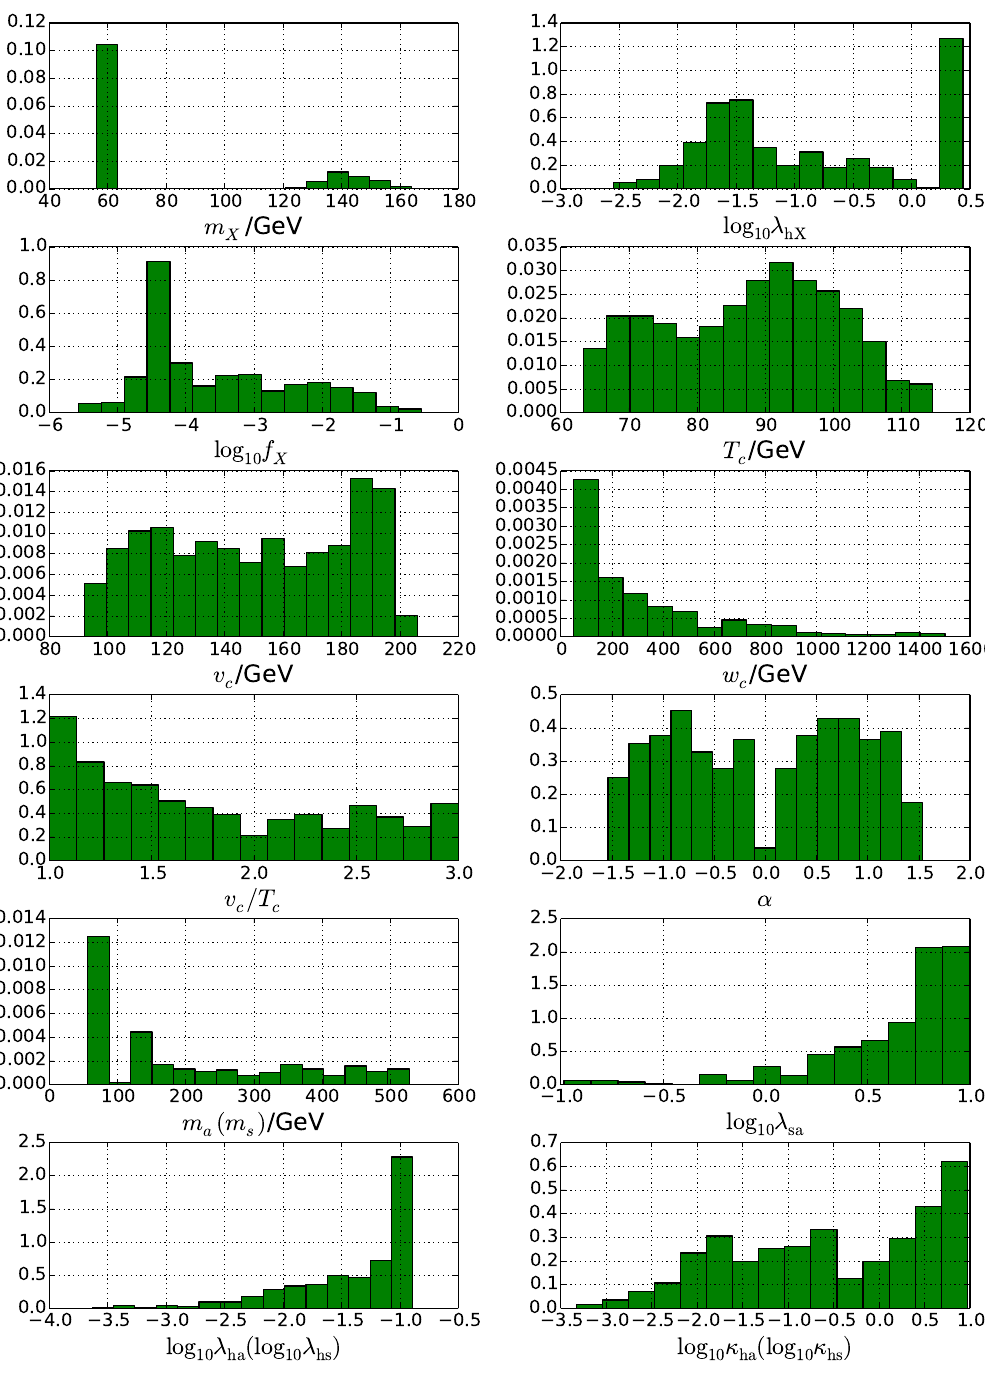
Figure 1 . The distributions of the parameters for the points satisfying the strongly (cid:12)rst-order PT conditions and all the DM constraints. Note that since s and a are equivalent in the scalar potential, the distributions for the couplings (cid:21) hs and (cid:21) ha are essentially the same, so are for couplings (cid:20) hs and (cid:20) ha . Thus, we only show one plot for either pair of couplings.